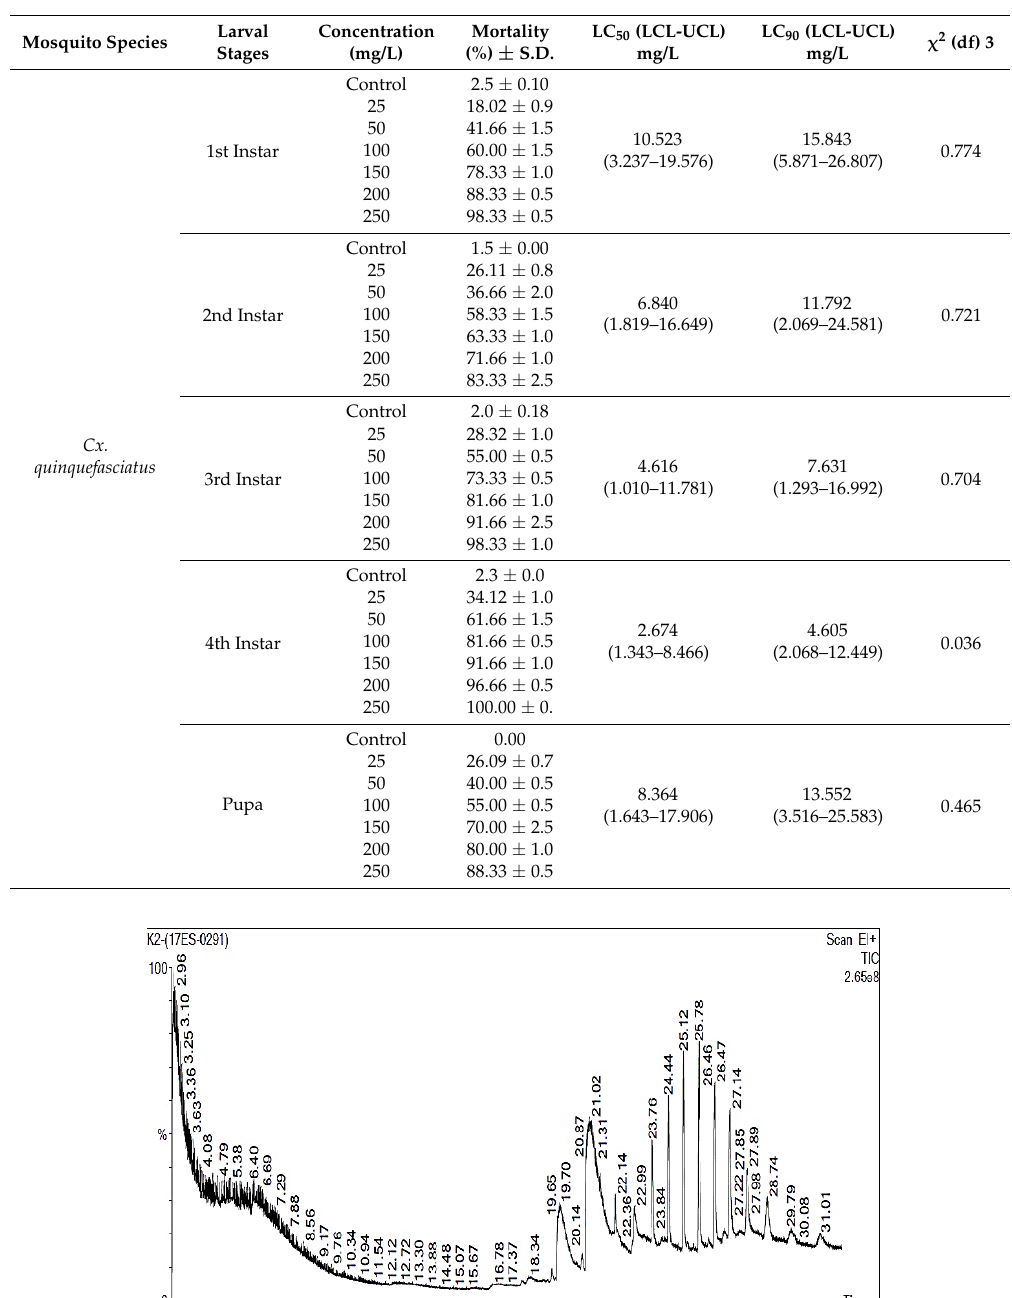
Table 2. Larvicidal and pupicidal activity of commercial insecticide B. bassiana -22 fungal mycelium extract (ethyl acetate) against larvae and pupa of Cx. quinquefasciatus (after 24 h of exposure).